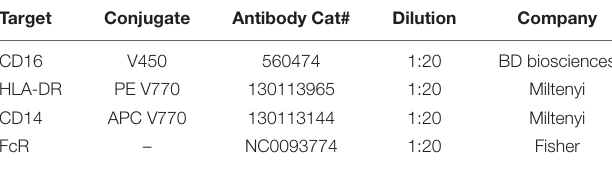
TABLE 2 | Flow-cytometry monocyte marker antibody